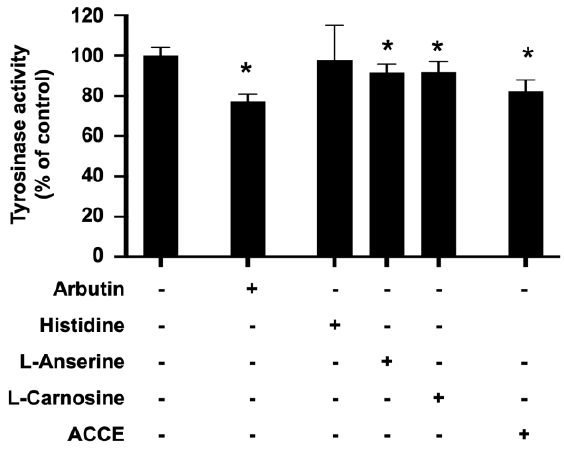
Figure 3. Effect of L-anserine, L-carnosine, and ACCE on cellular tyrosinase activity. Inhibitory effect of ACCE (2.0 × 10 4 µ g/mL), L-anserine (240 µ g/mL or 1 mM), and L-carnosine (226 µ g/mL or 1 mM) was measured against tyrosinase activity in the extract of MNT-1 cells. Histidine (155 µ g/mL or 1 mM) was used as the negative control. Arbutin (272 µ g/mL or 1 mM) was used as the positive control. Compared with the non-treated control, the p < 0.05 by Student’s t -test was defined by the star (*).